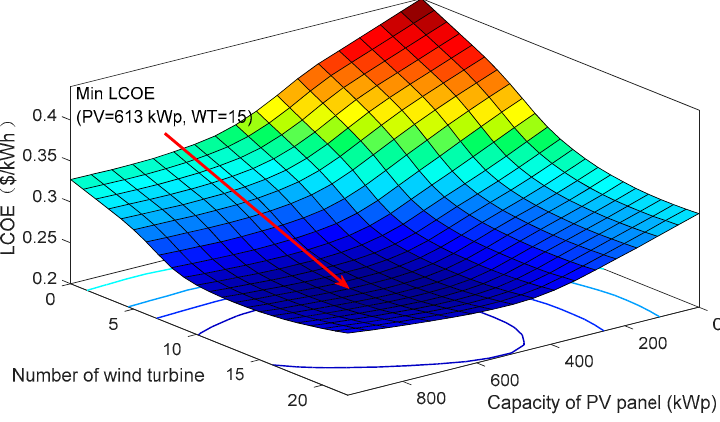
Figure 5. LCOE for different sizes of PV panels and wind turbines.